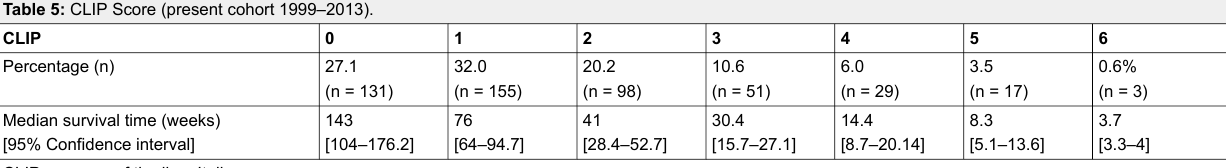
Table 5: CLIP Score (present cohort